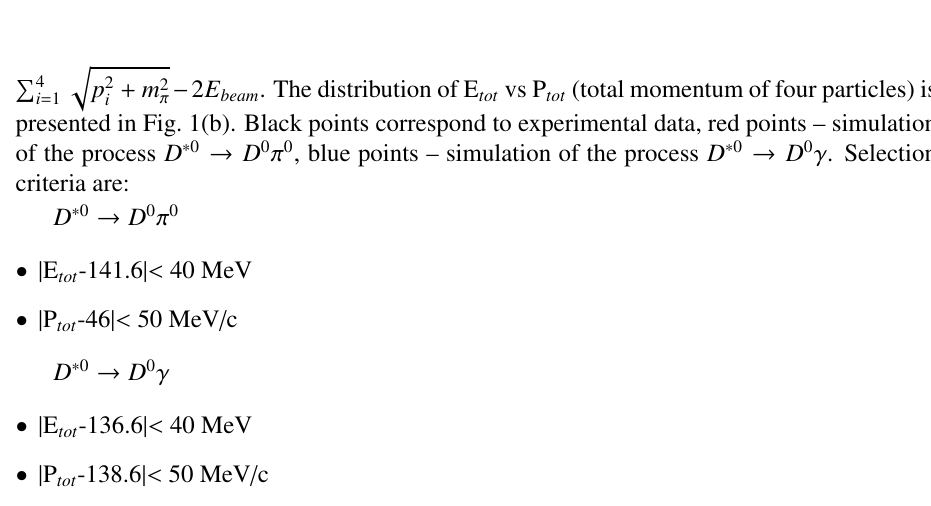
Figure 1. a.) E tot vs P tot . Black points correspond to experimental data, red points – D ∗ 0 → D 0 π 0 sim- ulation, blue points – D ∗ 0 → D 0 γ simulation. b.) L K πππ value for D ∗ 0 → D 0 π 0